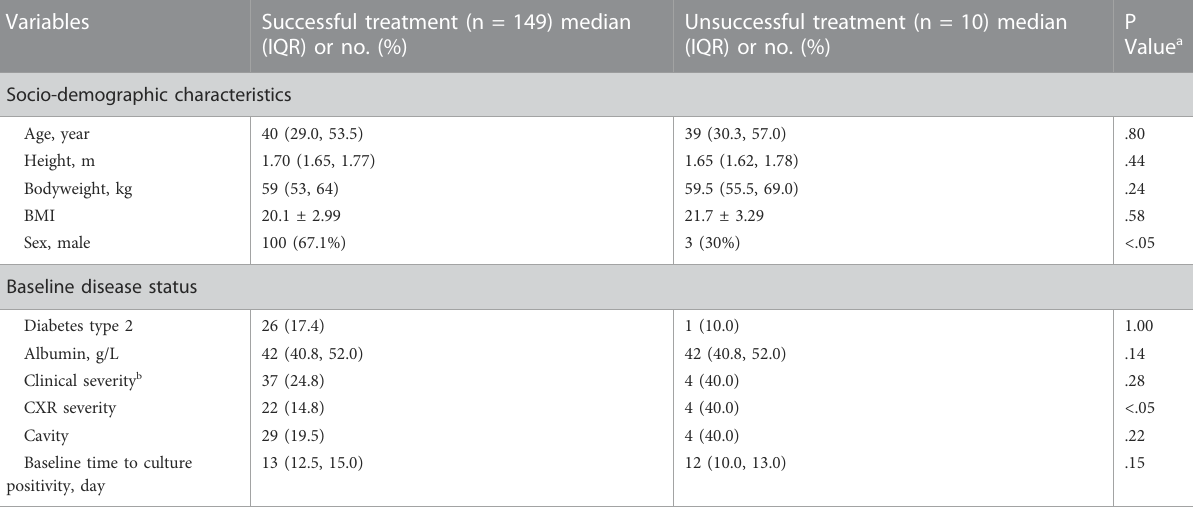
TABLE 4 Socio-demographic features and baseline disease status between groups with different treatment outcomes in validation